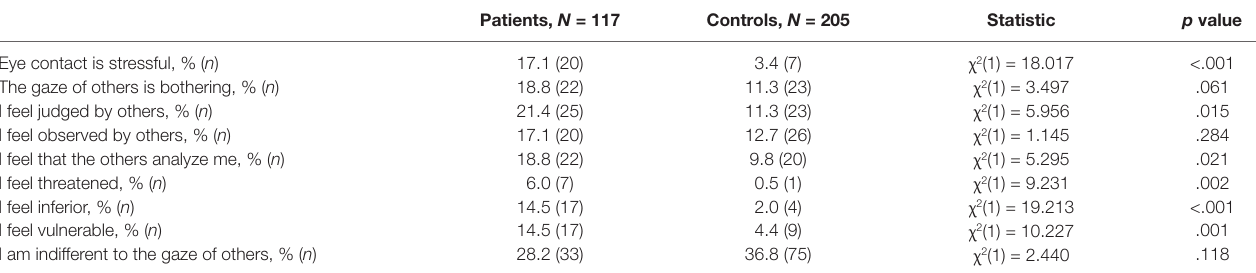
TABLE 2 | Perception of the gaze of